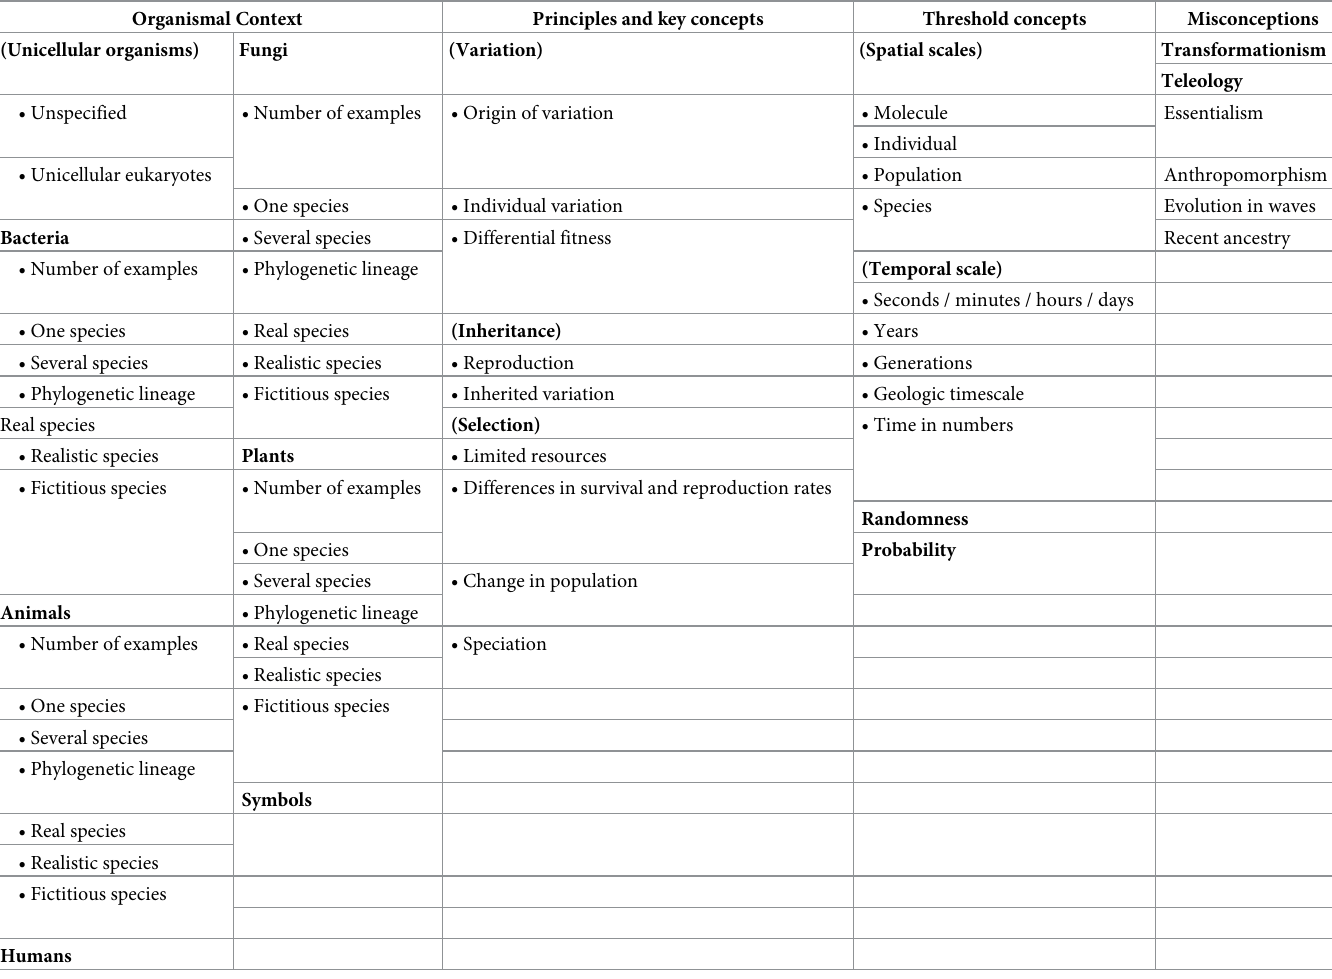
Table 1. List of variables assessed in the content analysis.